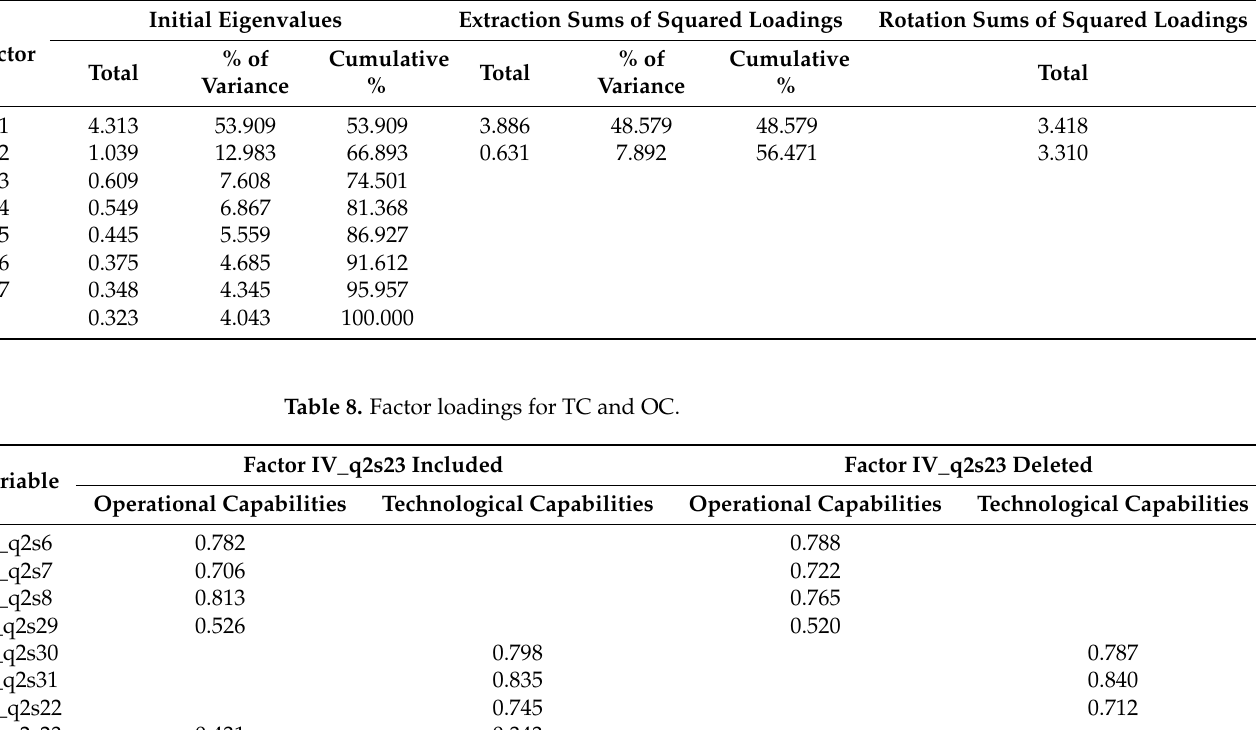
Table 7. Factor analysis results for variables IV_q2s22, IV_q2s23, V_q2s29, V_q2s30, V_q2s31, II_q2s6,